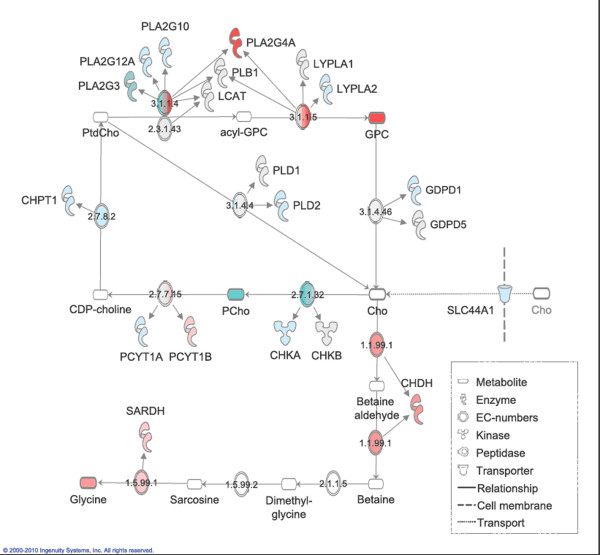
Differences in gene expression and metabolite concentrations. Differences in intracellular choline metabolism, choline transport and glycine formation between basal-like and luminal-like xenografts. Red: higher gene expression/metabolite concentration in basal-like xenografts. Blue: higher gene expression/metabolite concentration in luminal-like xenografts. White: Non-significant difference in expression/concentration. Log2-fold difference between models is indicated by color intensity. Only significantly differentially expressed genes are illustrated at each EC number, which represents specific enzymatic reactions. The metabolites which were measured with HR MAS MRS are outlined with a thicker line.